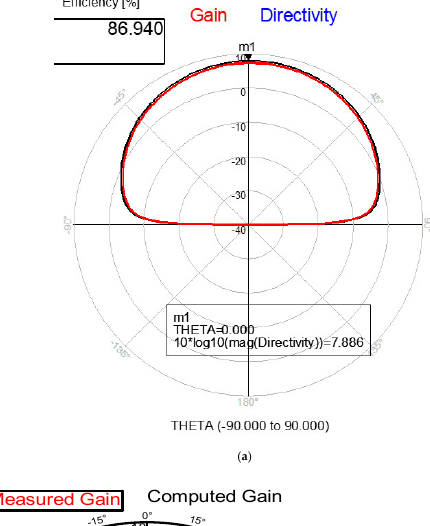
Figure 3. ( a ) Radiation pattern of the circular polarized, at 2.6 GHz. ( b ) Comparison of computed and measured.